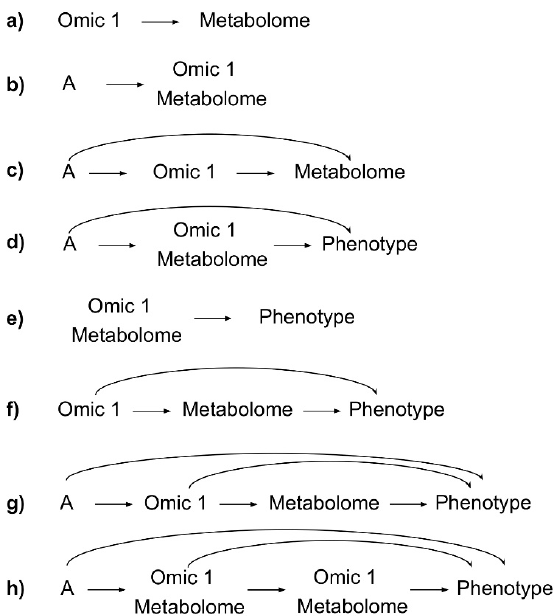
Figure 3. ( a – h ) Examples of multi-omic research questions that can be addressed in a multi-omic, longitudinal study design, represented as directed acyclic graphs. Time flows from left to right, to indicate distinct points of data collection. A =